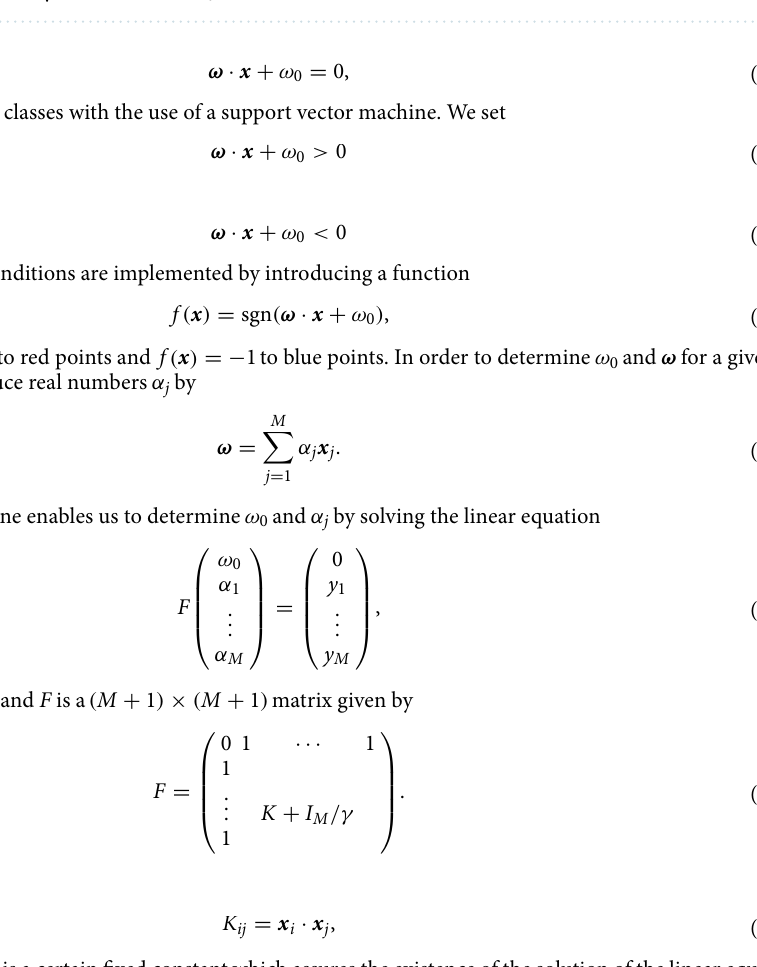
Figure 1. ( a ) Binary classification of red and blue points based on a quantum support vector machine with soft margin. A magenta (cyan) line obtained by an exact solution (variational method). ( b ) Evolution of the cost function. The vertical axis is the log 10 E cost . The horizontal axis is the variational step number. We have used r = 2 , ξ 1 = 0.001 and ξ 2 = 0.0005 and γ = 1 . We have runed simulations ten times, where each simulation is plotted in different color. ( c ) The saturated value of the cost function log 10 E opt as a function of ξ 2 ranging 10 − 1 ≤ ξ 2 ≤ 10 − 5 for various ξ 1 . The green dots indicates ξ 1 = 0.0001 , black dots indicates ξ 1 = 0.001 , magenta dots indicates ξ 1 = 0.01 and cyan dots indicates ξ 1 = 0.1